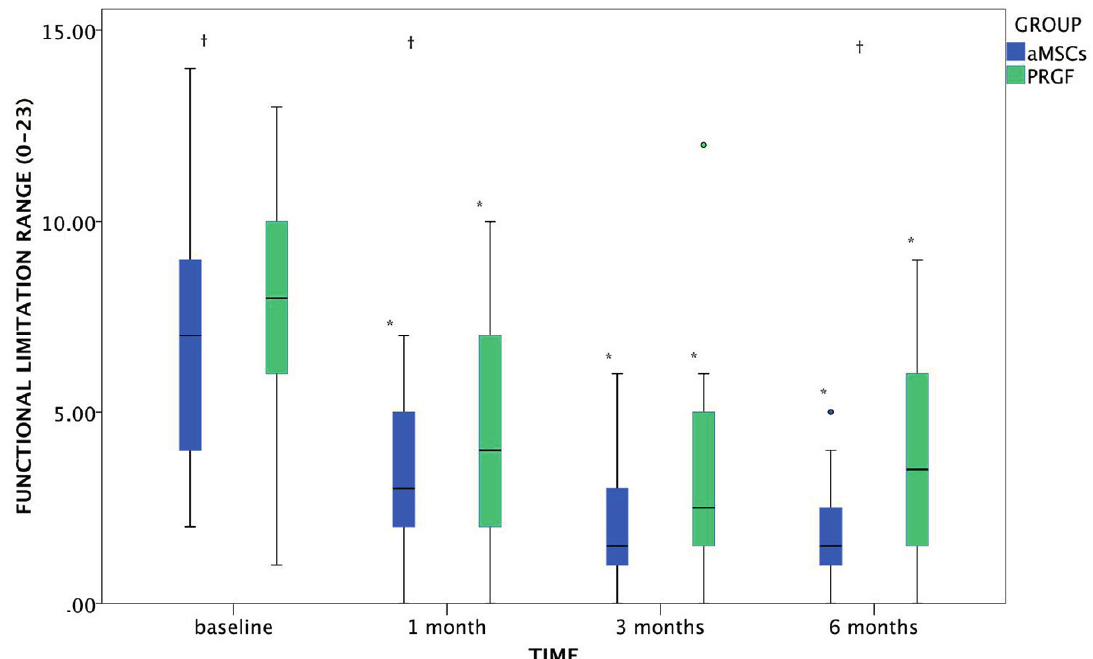
Figure 3. Evolution of functional limitation (range: 0–23) in dogs after aMSCs or PRGF treatment at the 6-months follow up period. The changes which differed significantly with baseline ( p < 0.05) are marked as * . Statistically significant differences between groups are marked as †. Circles, both green and blue, correspond to outlier included in the statistical